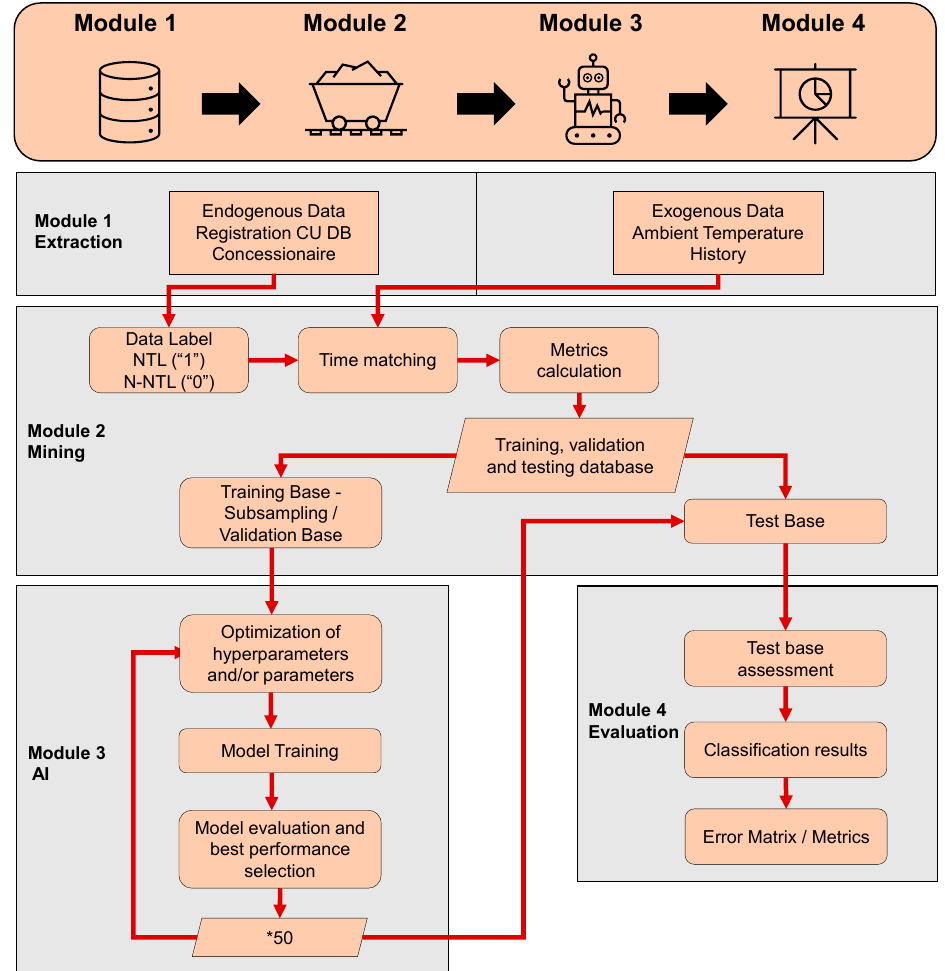
Figure 1. Flowchart of the proposed methodology. *50 means that Hyperparameter optimization 50 training iterations.